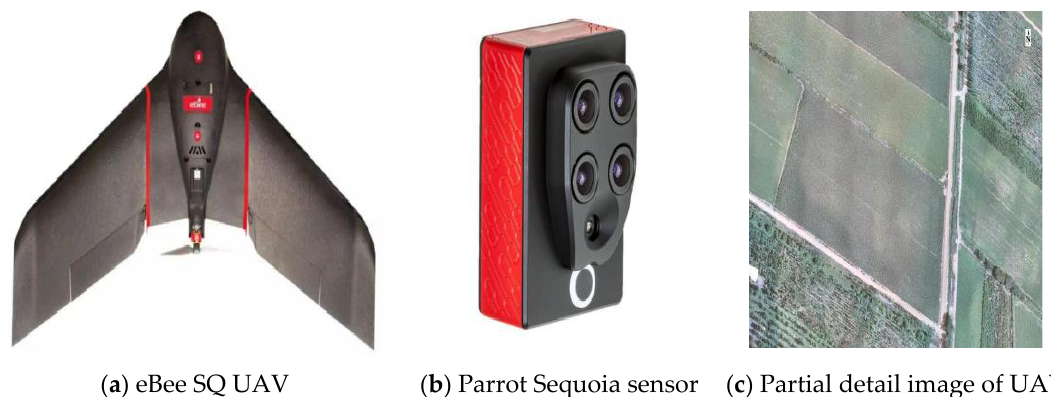
Figure 3. UAV ’ s platform, sensor, and partial detail images. Figure 3. UAV’s platform, sensor, and partial detail